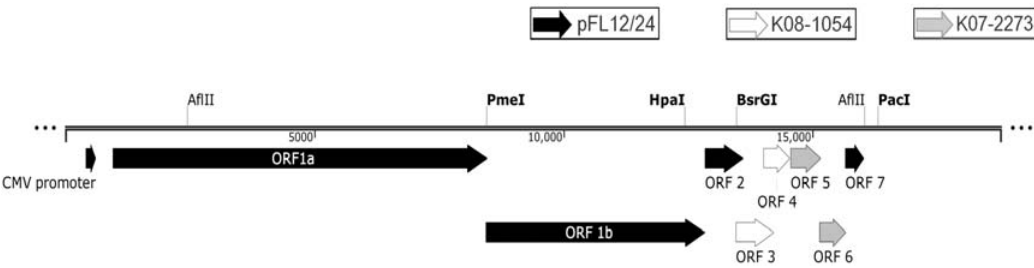
Figure 1. Graphical representation of the genomic construct for the chimeric infectious clone (pFLK 3–6 ). Black, white, and gray arrows represent the open reading frames (ORFs)/gene fragments from pFL12/24, K08 ‐ 1054, and K07 ‐ 2273, respectively. The restriction sites used for cloning are listed above the construct. CMV: human cytomegalovirus; AflII, BsrGI, HpaI, PacI, PmeI: restriction sites.